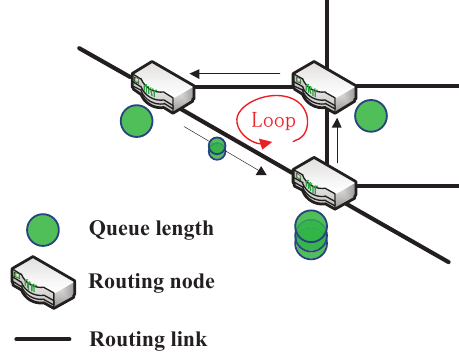
Figure 2. Loop routing problem in routing